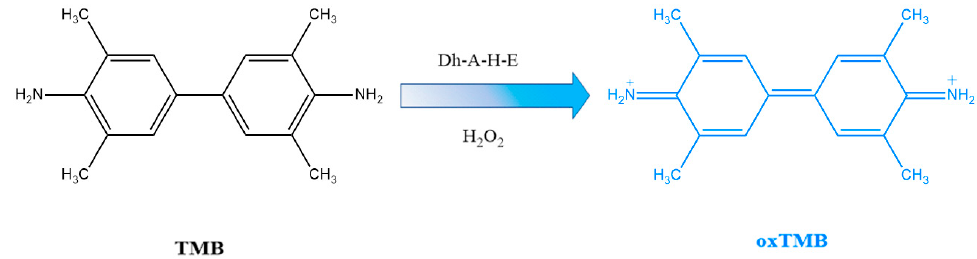
Figure 1. UV absorption of ( 1 ) Dh–A–H–E + 3,3’,5,5’–tetramethylbenzidine (TMB), ( 2 ) TMB + H 2 O 2 , and ( 3 ) Dh–A–H–E + TMB + H 2 O 2 .